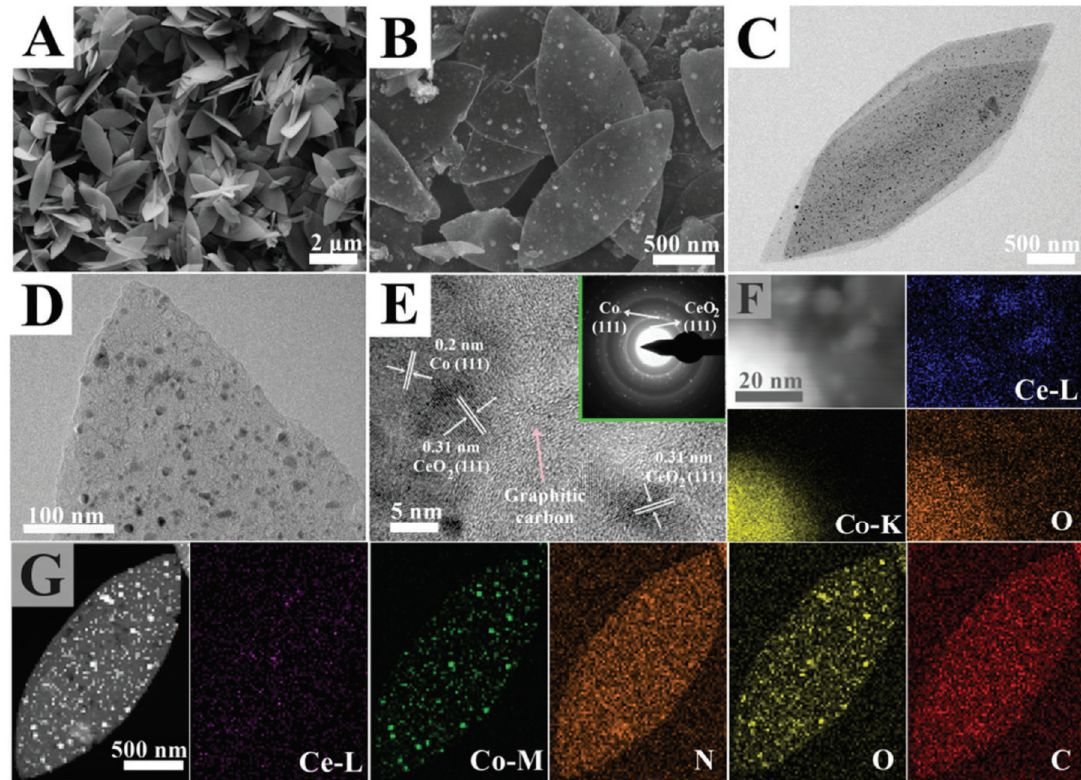
Figure 15. ( A , B ) FESEM and ( C , D ) TEM images of the ceria@2D-hexagonal-leaf-like hierarchical porous Figure 15. ( a , b ) FESEM and ( c , d ) TEM images of the ceria@2D-hexagonal-leaf-like hierarchical porous carbon nanosheet (Ce-HPCN) catalyst. ( E ) HR-TEM image showing the presence of Ce / Co in the carbon nanosheet (Ce-HPCN) catalyst. ( e ) HR-TEM image showing the presence of Ce/Co in the Ce- Ce-HPCN catalyst (inset in ( E ): Selected area electron di ff raction (SAED) pattern of Co and CeO 2 ) and HPCN catalyst (inset in ( e ): Selected area electron diffraction (SAED) pattern of Co and CeO 2 ) and ( f ) ( F ) the corresponding STEM-EDS mapping images. ( G ) STEM and elemental mapping images showing the corresponding STEM-EDS mapping images. ( g ) STEM and elemental mapping images showing the homogenous distribution of Ce, Co, N, C, and O in a leaf-like lamella. Reprinted with permission from reference [109]. Copyright (2018) Royal Society of